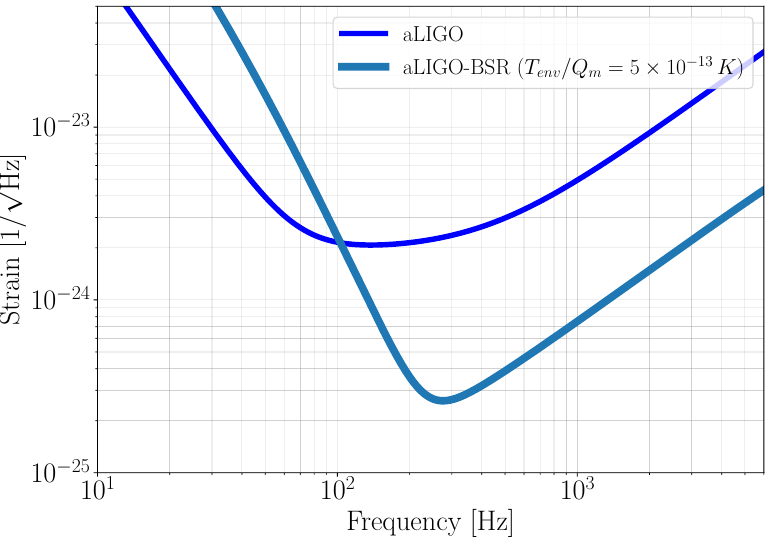
Figure 3. This figure shows the quantum noise spectral densities of aLIGO and with BSR scheme ( T env / Q m = 5 10 − 13 ). 15dB squeezing is assumed in the arm cavity and × observed under 10% external